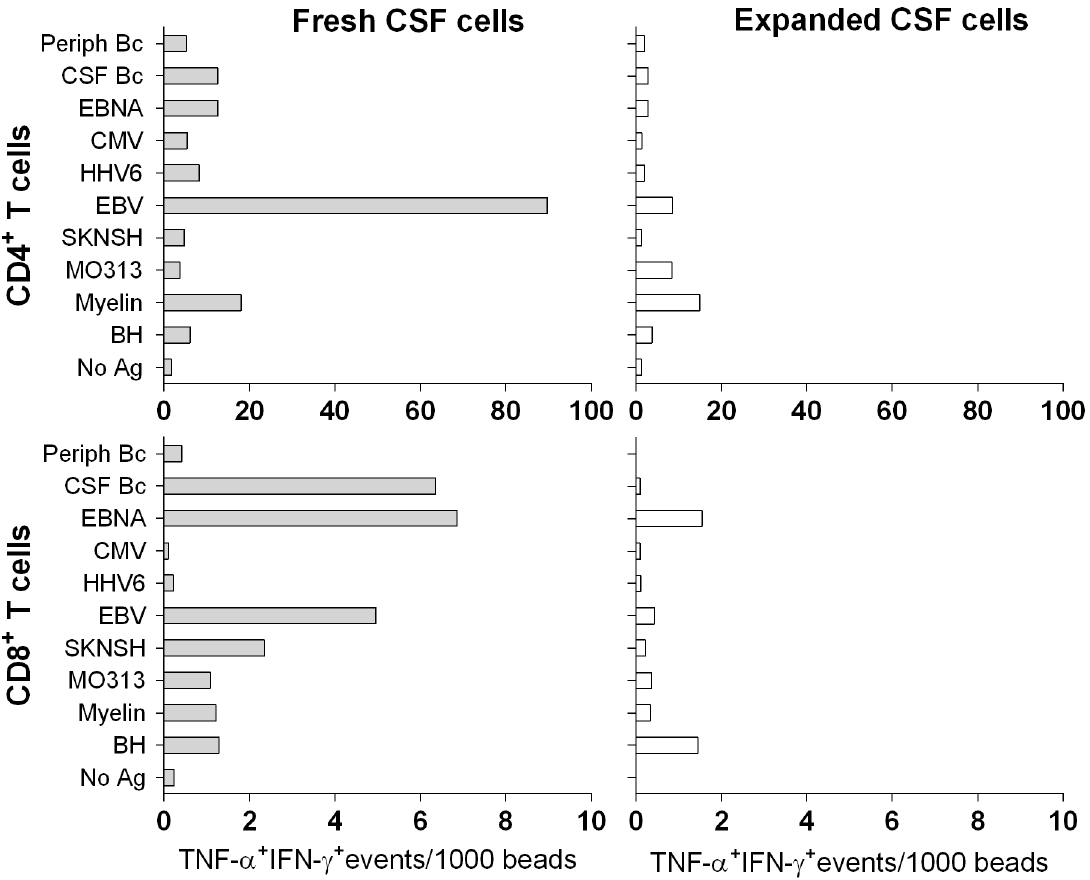
Figure 2. Reduced Ag-specific responses of polyclonally expanded as compared to fresh intrathecal T cells. T cell reactivities of fresh (filled bars) and polyclonally expanded CSF T cells (open bars) from one representative research subject (n=3) were analyzed using co-cultures with autologous Ag-loaded DCs. TNF- a + IFN- c + T cell events were standardized to 1000 beads and are depicted for CD4 + (upper panels) and CD8 + T cells (lower panels).